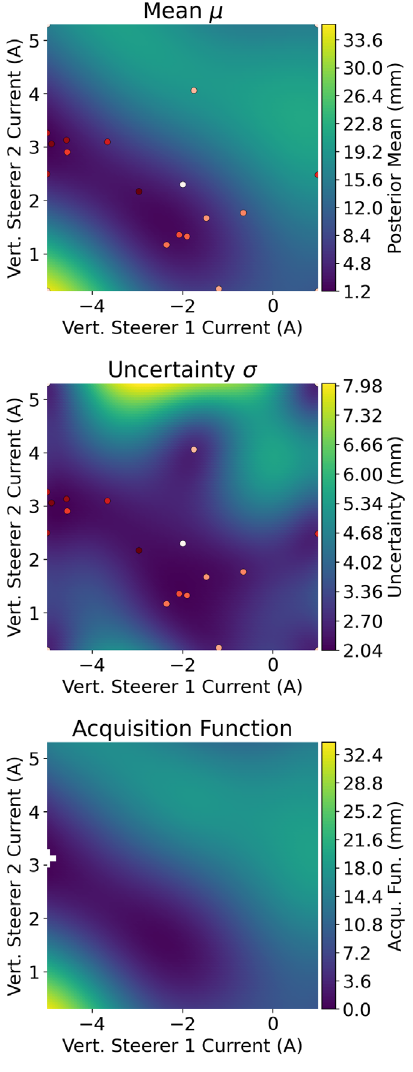
FIG. 2. Mean μ (a), standard deviation σ (b) and acquisition function (c) for a 2D steerer optimization run. The observations are shown in (a) and (b) by dots shaded by time of observation, with the darkest shade being the most recent observation. The next sample point is shown in (c) by the white cross indicating the minimum of the LCB acquisition function.